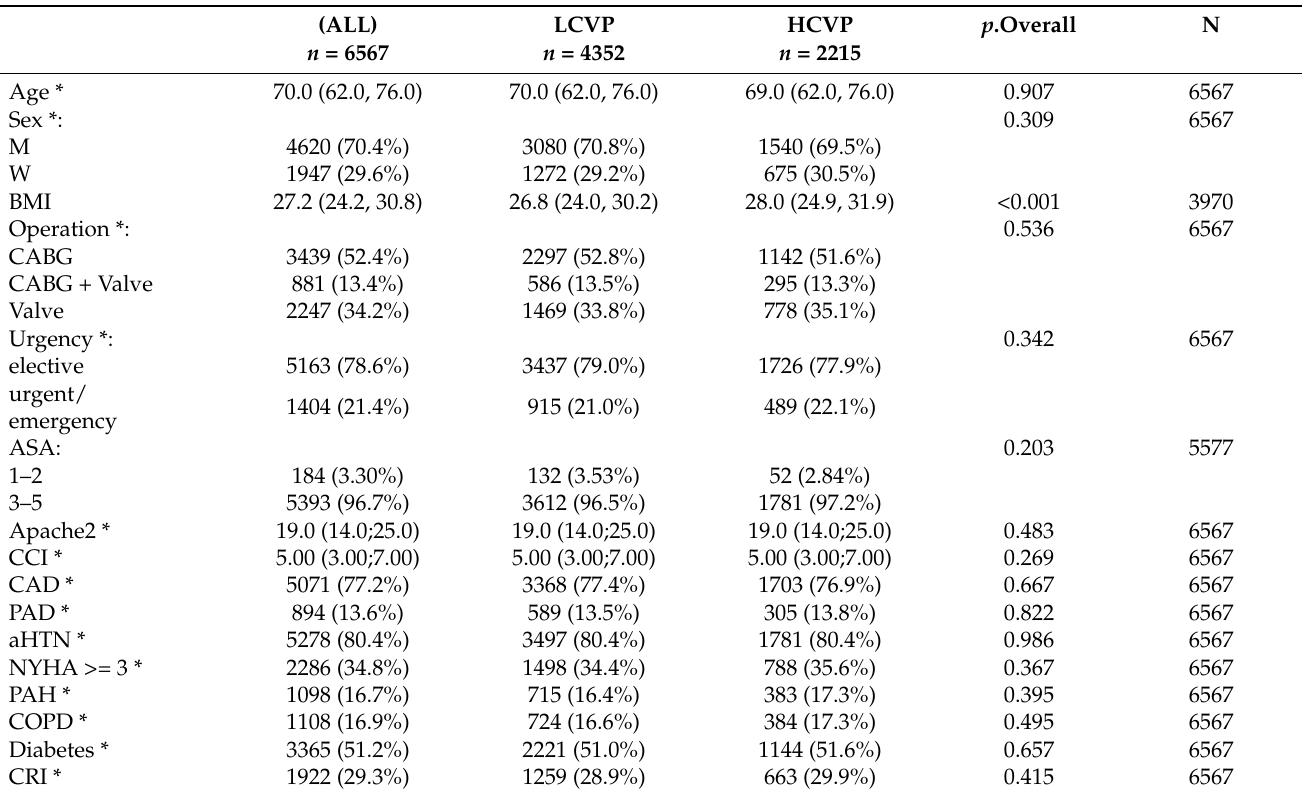
Table 1. Morphometry of matched